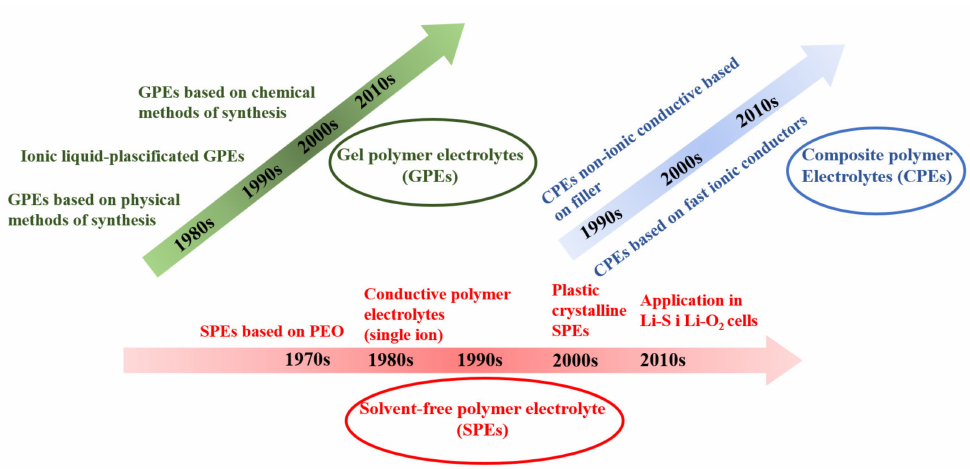
Figure 5. Chronological development of polymer electrolytes for non-aqueous lithium-based cells in the years